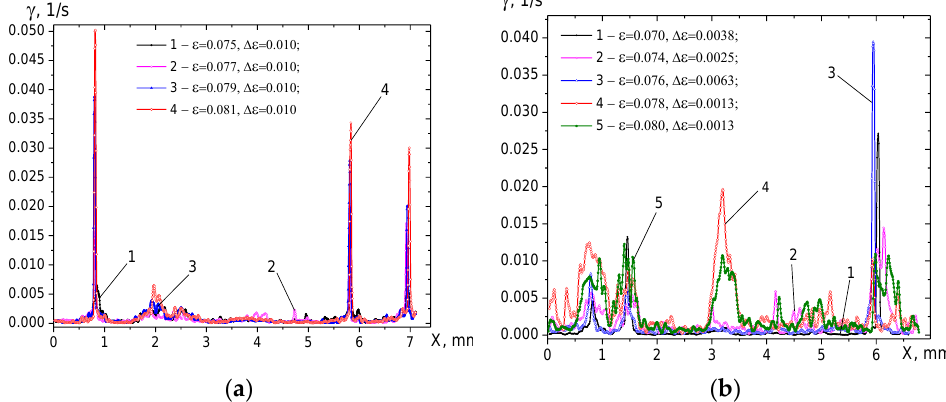
Figure 16. Spatial distribution of CPS rate γ (x, y = Y m /2), measured along the midline of Specimen #1 ( a ) and Specimen #4 ( b ) at the deformation Stage IV .